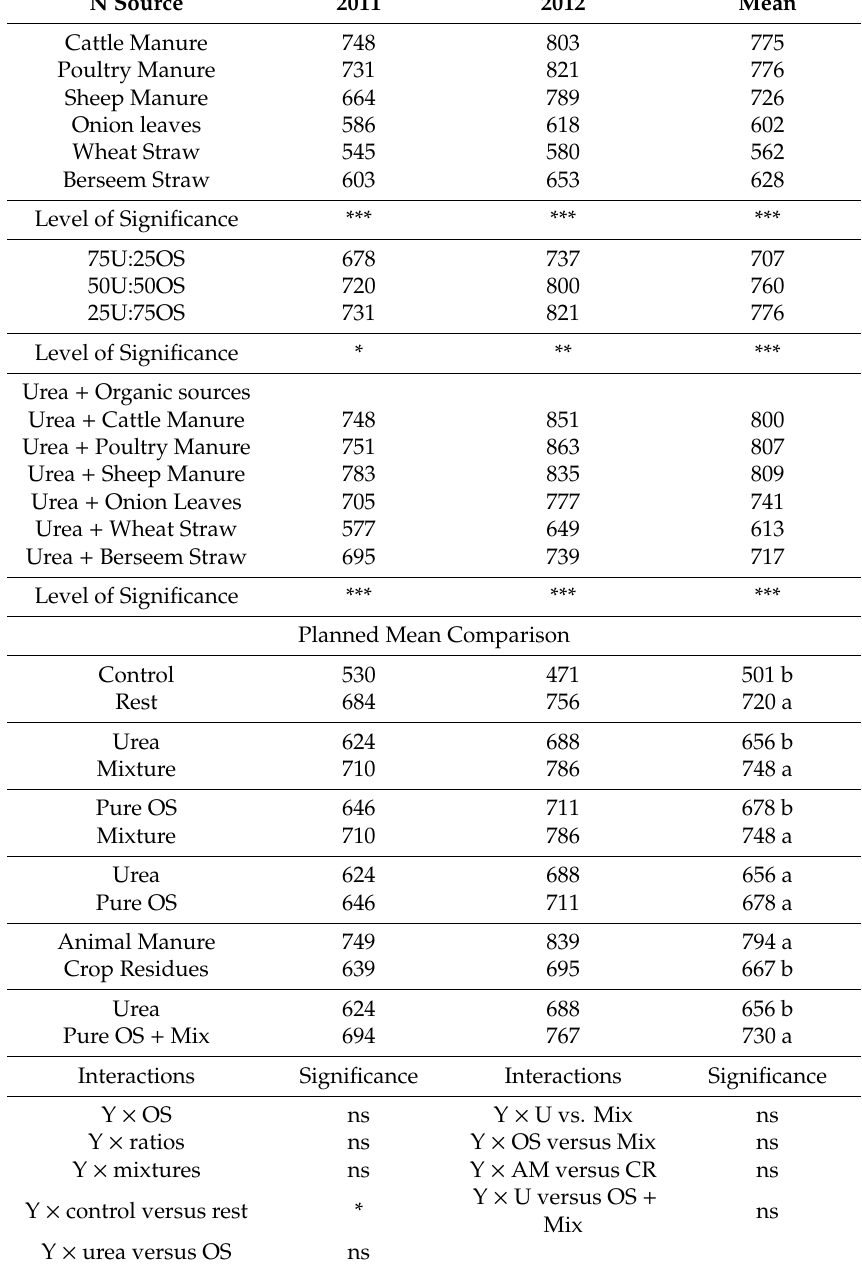
Table 2. Soil nitrogen concentration (mg kg − 1 ) after harvesting of rice hybrid “Pukhraj” as a ff ected by organic and inorganic